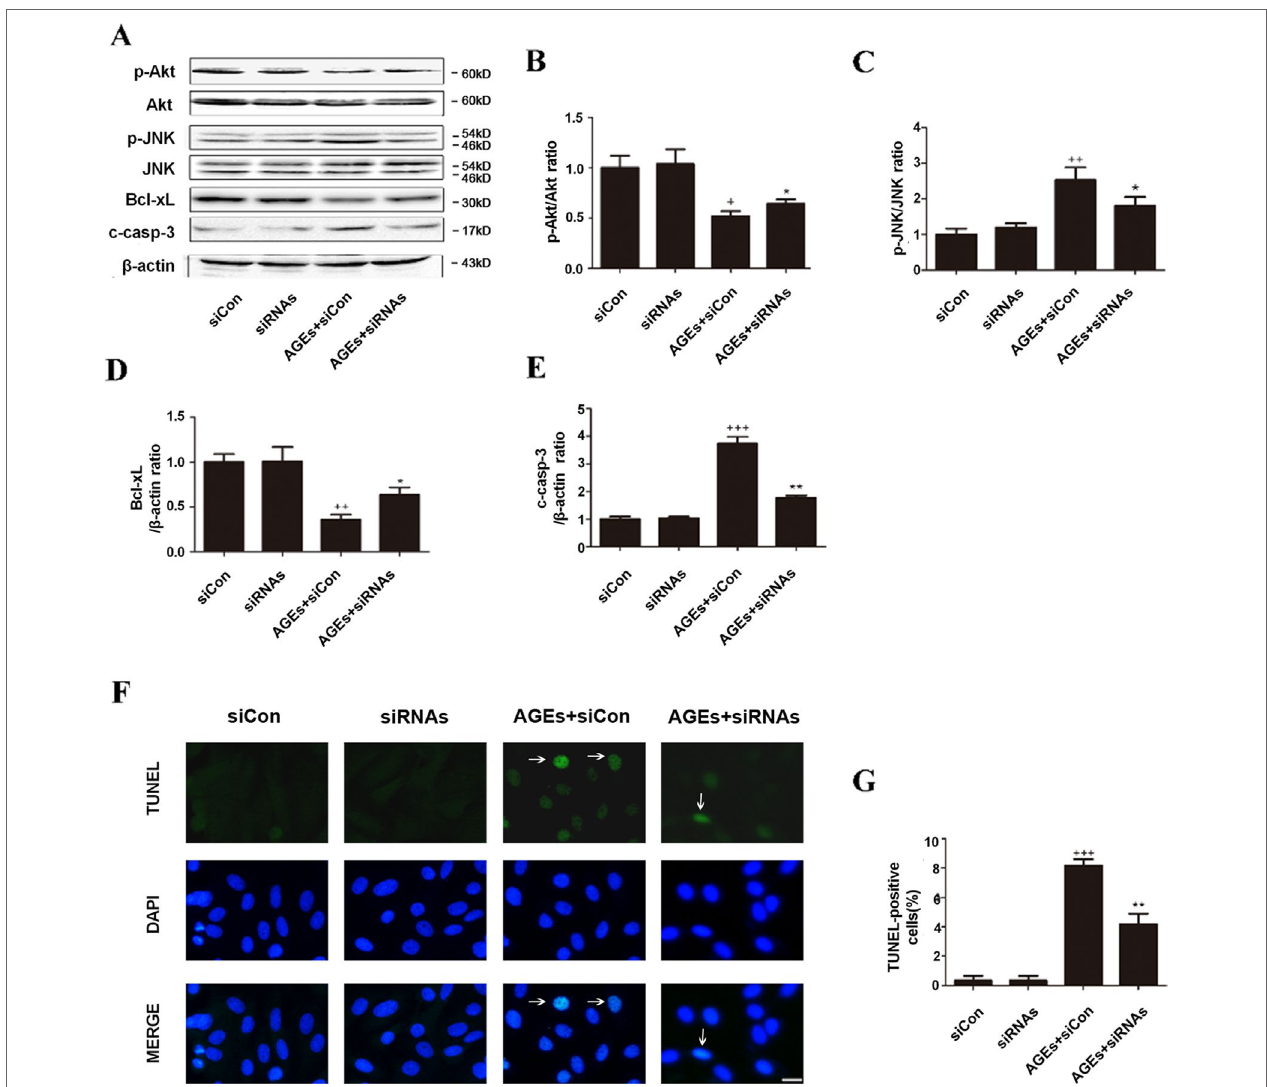
FIGURE 6 | Inhibition of CYP4A by siRNAs protects H9c2 cells from AGEs-induced apoptosis. (A – E) Protein expression of p-Akt, p-JNK, Bcl-xL, and c-caspase-3, n = 3. (F) Relative apoptosis rates are represented as TUNEL-positive cells/DAPI-positive cells, n = 6. (G) Apoptosis via TUNEL staining. H9c2 cells at a density of 1 × 10 5 cells per well were seeded on six-well plates and transfected at 70–80% confluence with siRNAs against rat CYP4a1, CYP4a2, CYP4a3, or nonbinding control siRNA. Transfection was performed with Lipofectamine 2000. After 24 h of CYP4a siRNAs transfection, cells were treated with 10 μ M AGEs or BSA for 24 h. Scale bar = 10 μ m. siCon: siControl. siRNAs: siRNAs against CYP4a1, CYP4a2, and CYP4a3. Compared with the siCon group, + p < 0.05, ++ p < 0.01, +++ p < 0.001; compared with the AGEs+siCon group, *p < 0.05, **p < 0.01 (one-way ANOVA with Tukey post hoc